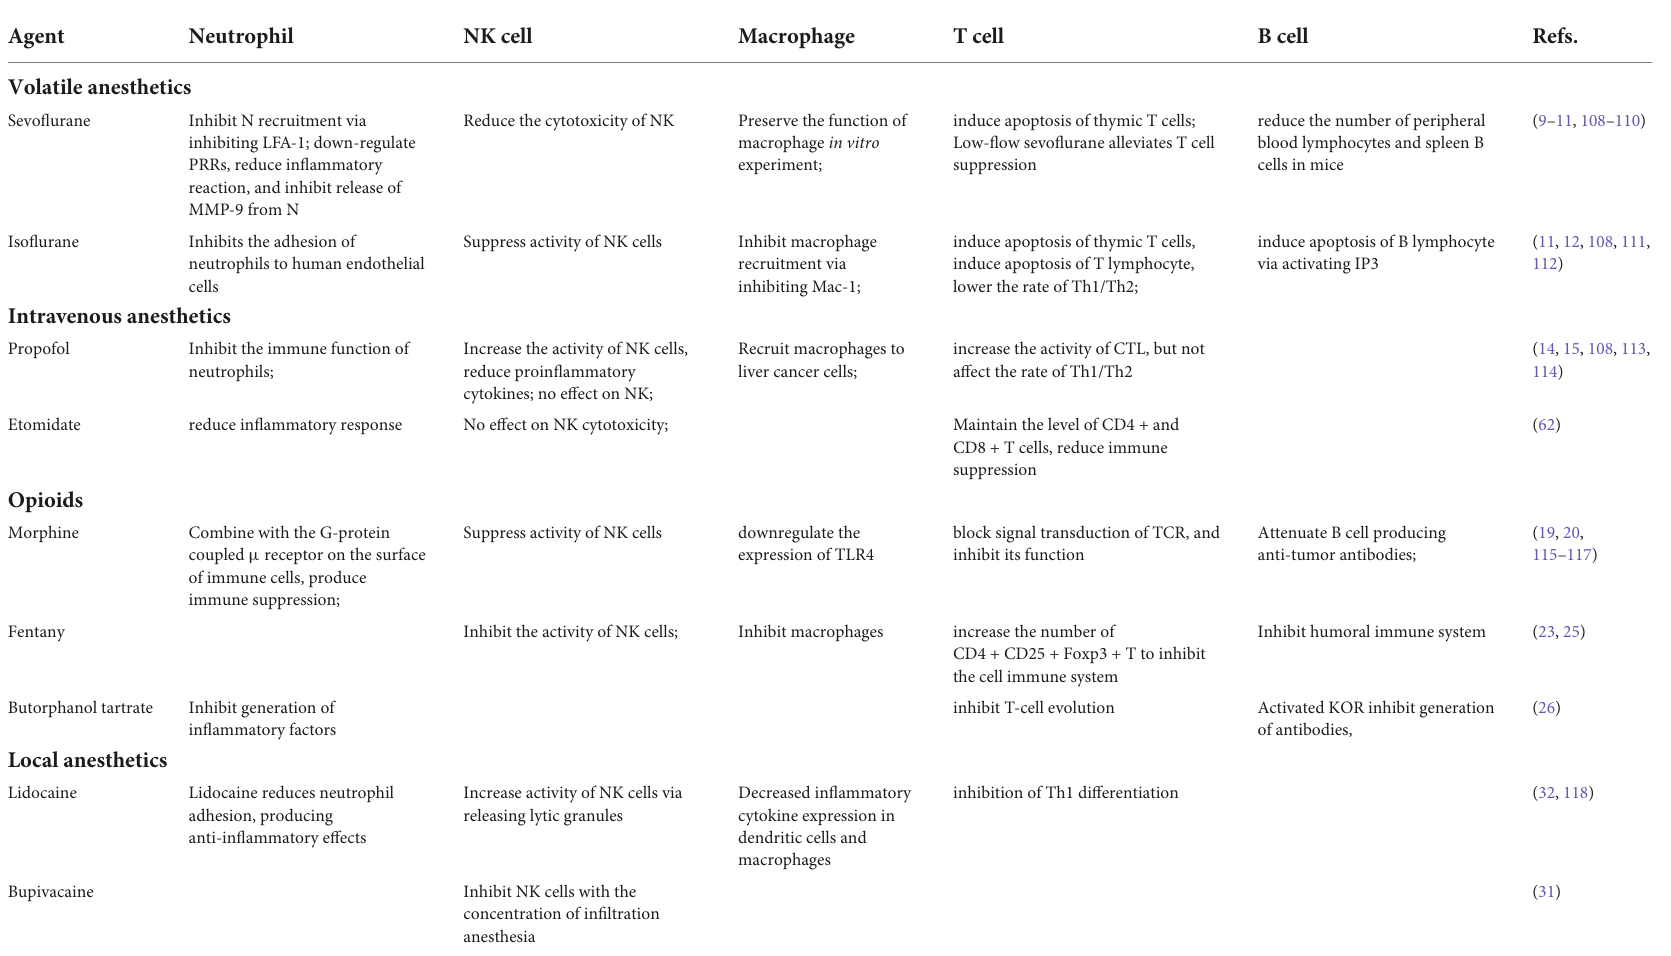
TABLE 1 Influence of various anesthetics on immune function.